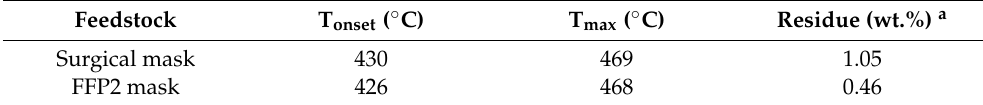
Table 1. Main features calculated from TGA curves of surgical and FFP2 FMs. Feedstock